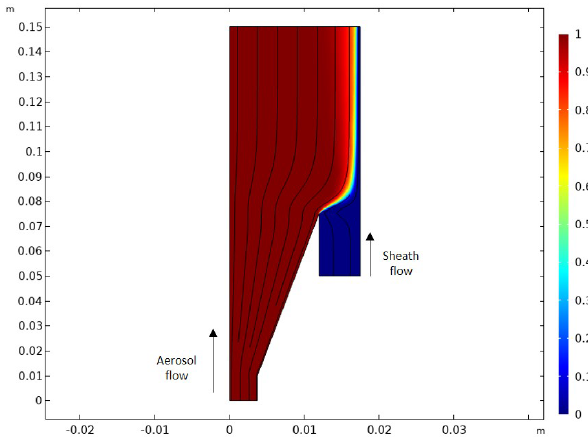
Figure A2. Result of a computational fluid dynamics simulation with original inlet design. The figure presents the half-side of a lon- gitudinal sectional view of Fig. A1b, and the x and y axes present the length of the inlet (units are meters). A solid black line and the color bar indicate the flow streamline in the velocity field and the relative particle concentration [molm − 3 ], respectively. It is noted that aerosol and sheath flow go from the bottom ( − y ) to the top ( + y ), as marked in the